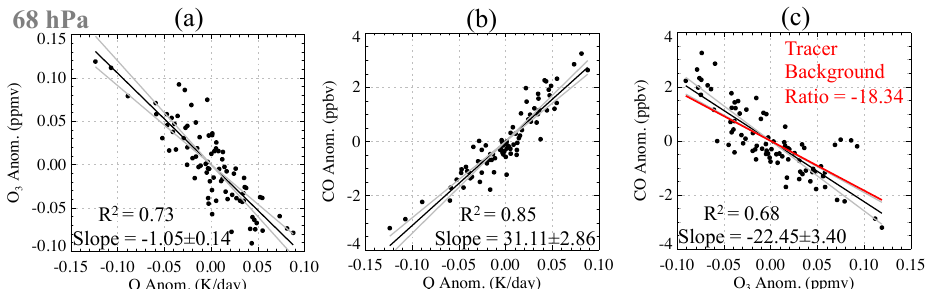
Fig. 13 For MERRA run with Average Kernel